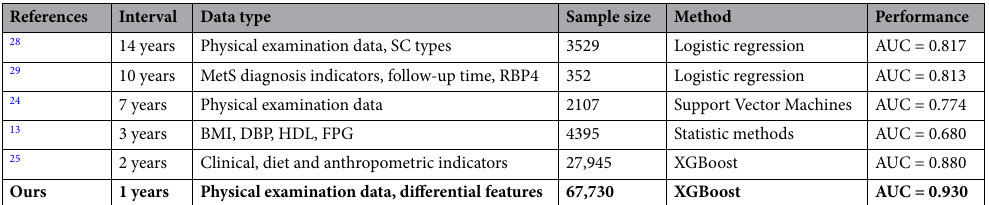
Table 7. Comparison between the proposed MetS model and the state-of-the-art contributions. The result with the best performance in each metric using different classifiers are marked in bold